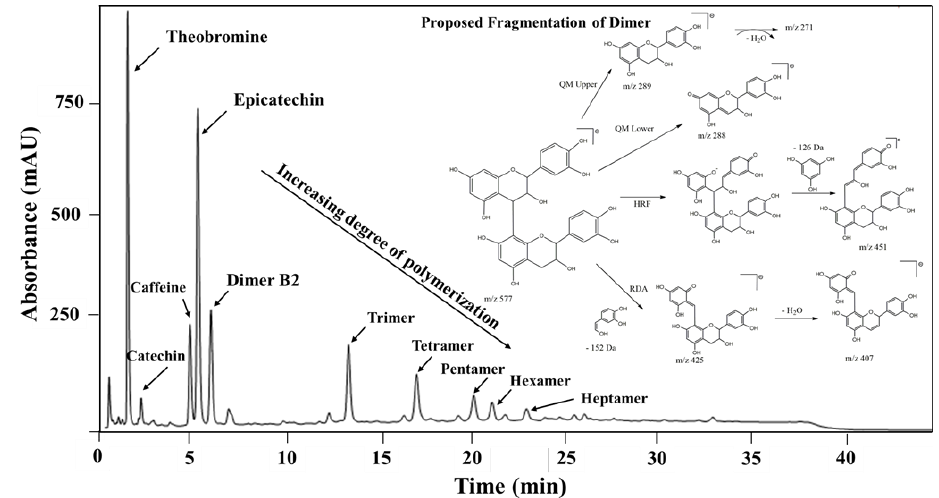
Figure 5. Chromatogram of cocoa extract and hypothetical electrospray ionization (negative mode) fragmentation pathway for procyanidin dimer. RDA, retro-Diels-Alder fission; QM, quinone methide cleavage; HRF, heterocyclic ring fission.